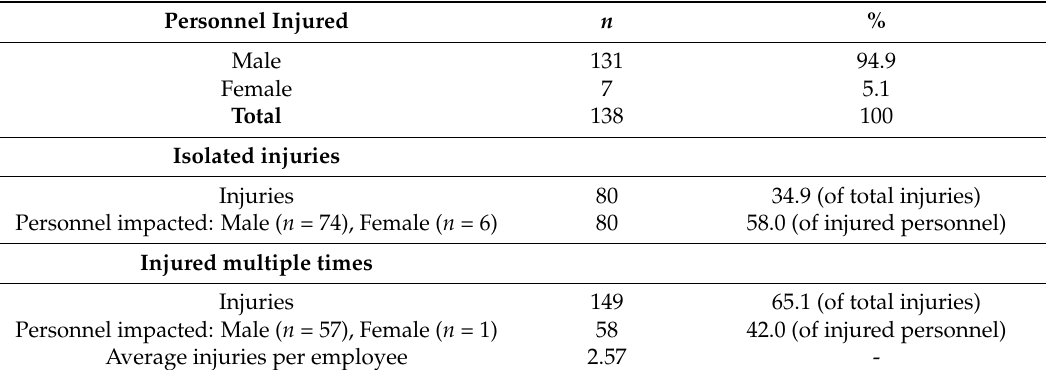
Table 1. Descriptive analysis of personnel injured during the April 2010–March 2014 period.